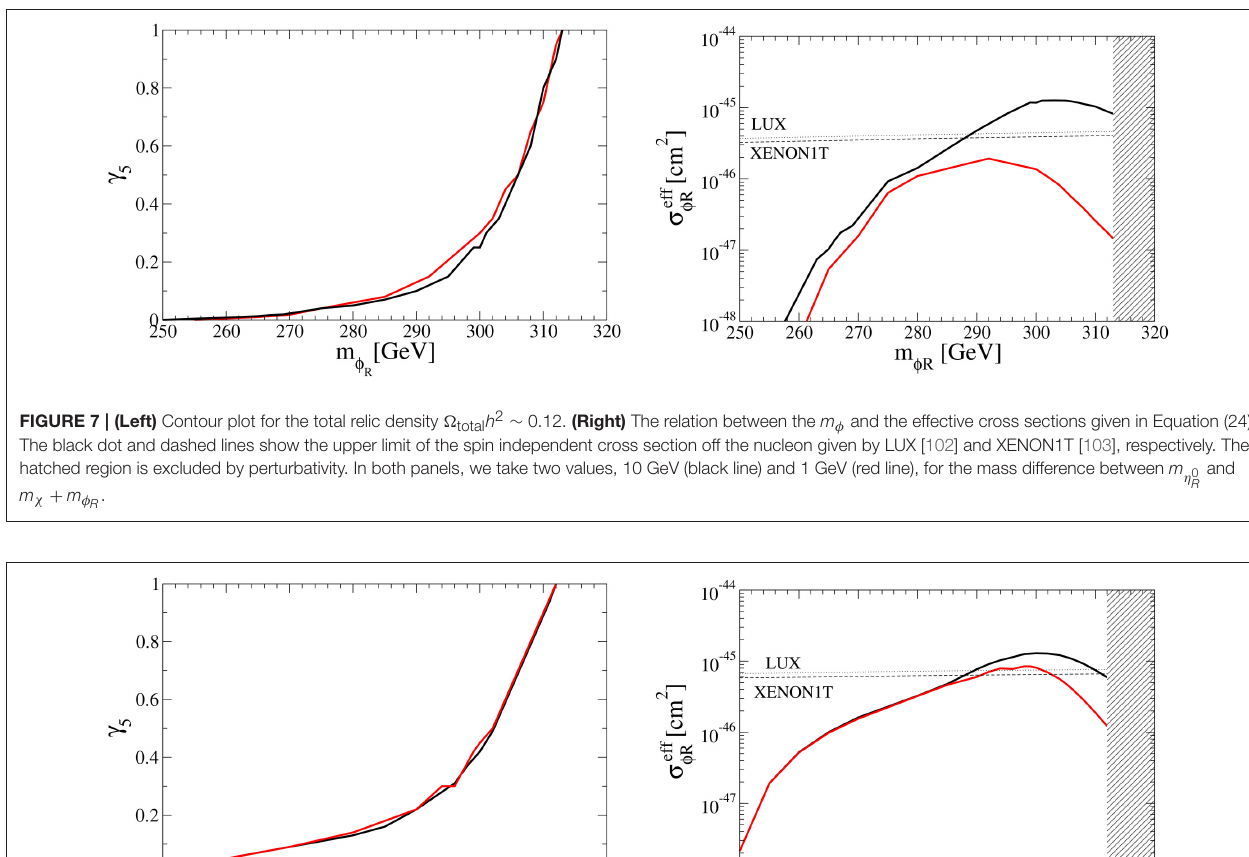
FIGURE 8 | The same as Figure 7 but for M 1